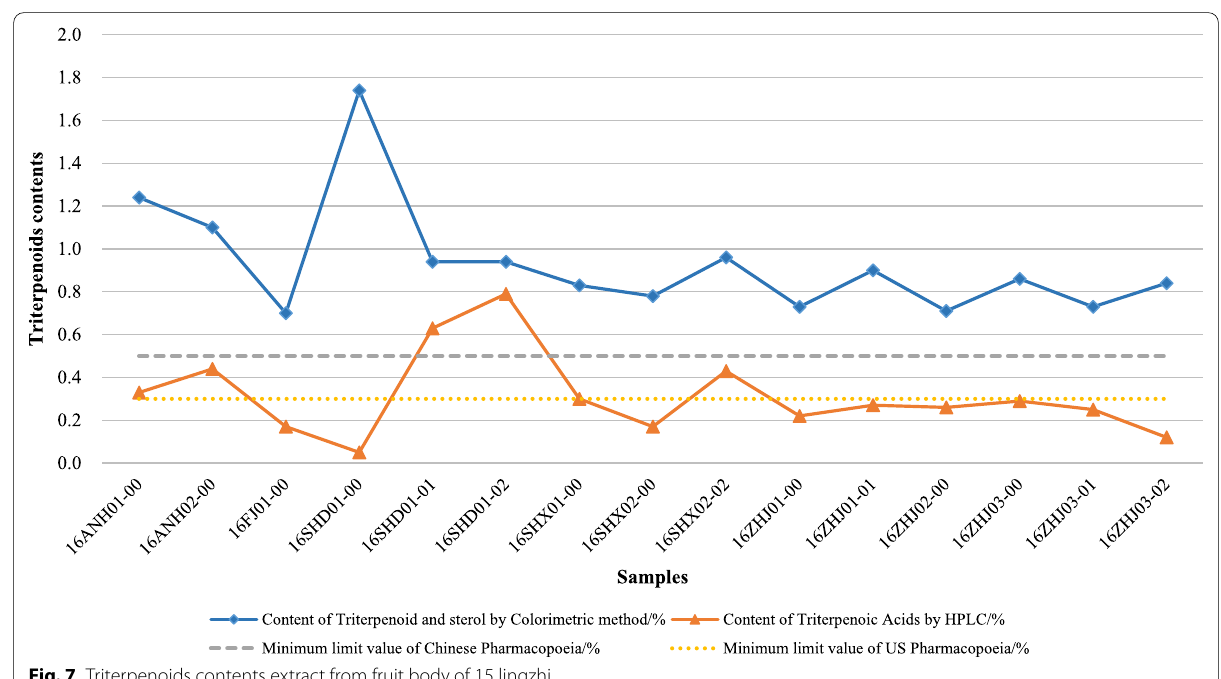
Fig. 7 Triterpenoids contents extract from fruit body of 15